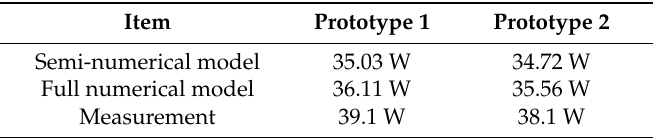
Table 4. Comparison of modeled core losses and measurements.